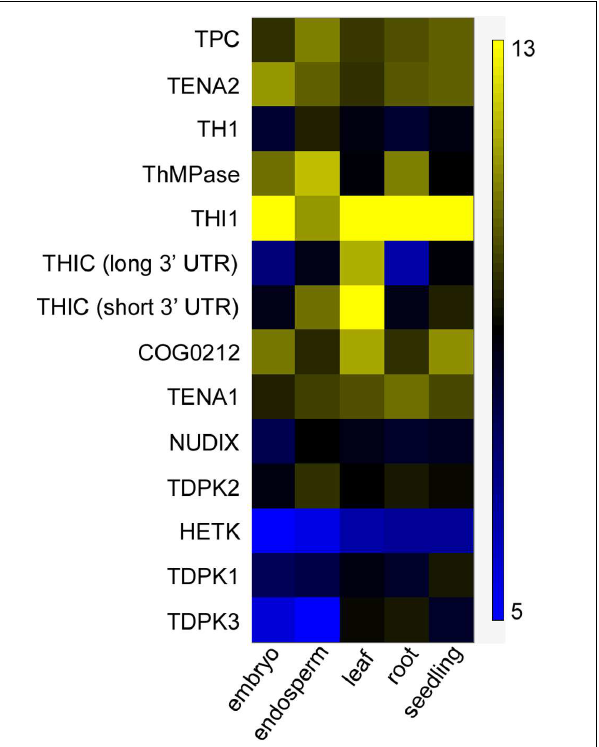
FIGURE 7 | Expression of thiamin metabolism genes in different organs in rice. Data were computed from the Rice Oligo Array Database using the Affymetrix platform (http://ricearray.org/index.shtml). Heatmap scale indicates log2 intensity of fluorescence. Embryo and endosperm of seed were collected at 6 days after anthesis. Leaves and roots were from 7-day-old seedlings. Seedlings samples were from 10-day-old seedlings. All tissues were from Oryza sativa japonica cultivar Zhonghua 11 cultivated at day/night temperatures 28/22 ◦ C in a phytotron.